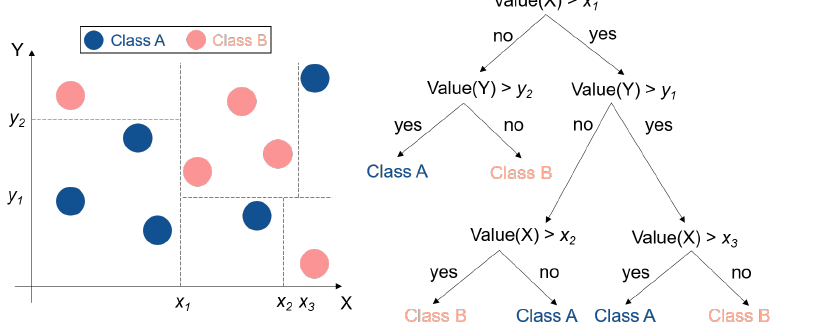
Figure 7. The principle of a decision tree. As shown, the feature space is partitioned into several rectangles in which the input point can find the corresponding class.